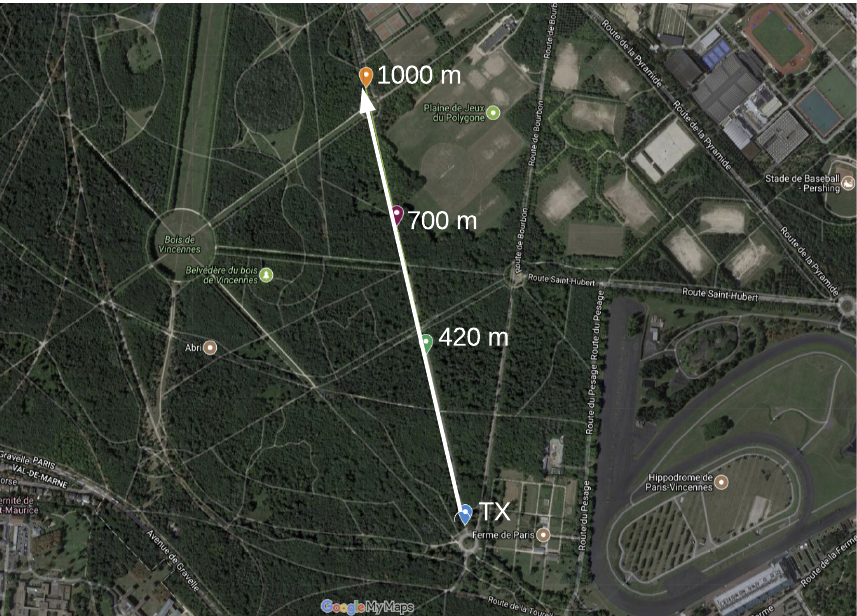
Figure 3. LoS scenario. Distances show where the RX nodes are placed away from the TX